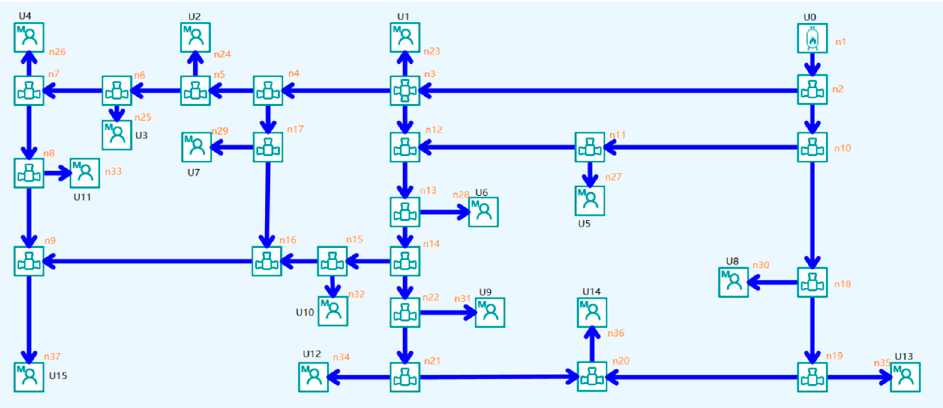
Figure 4. Supply water network in a DHS (diagram).